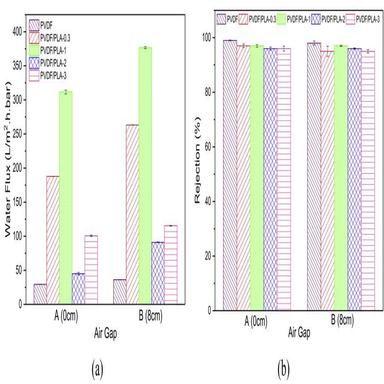
Performance of PVDF membranes with and without PLA modification at different air gap, (a) pure water flux and (b) HA rejection.